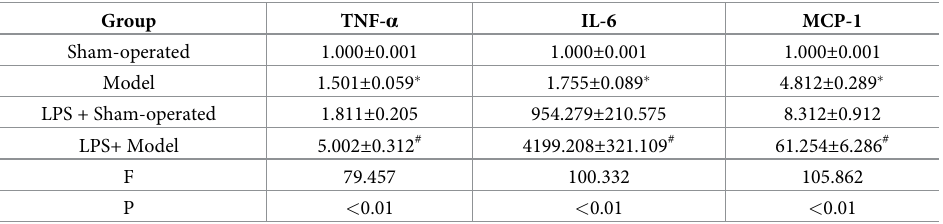
Table 1. Expression of M1 markers in peritoneal macrophages of rats in two